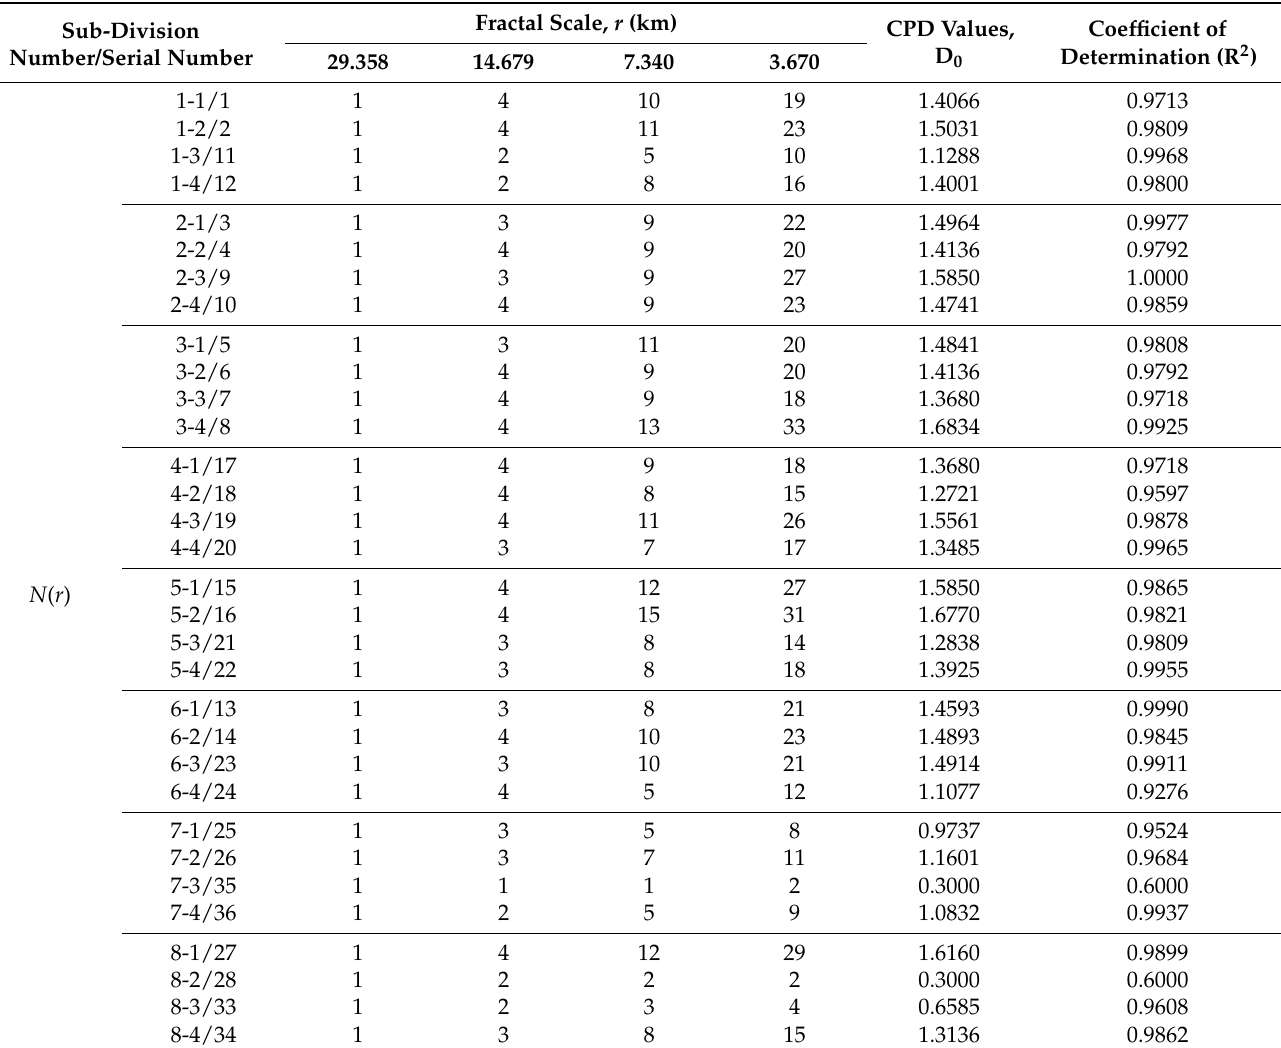
Table 6. Statistical table of subdivision for the capacity dimension (CPD) calculation